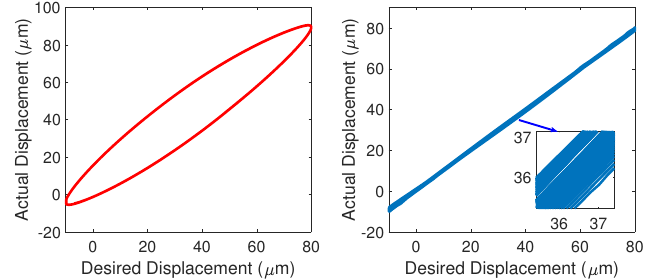
Figure 18. Hysteresis loops in 50 rad/s generated with open-loop status ( left ) and closed-loop status via the proposed strategy ( right